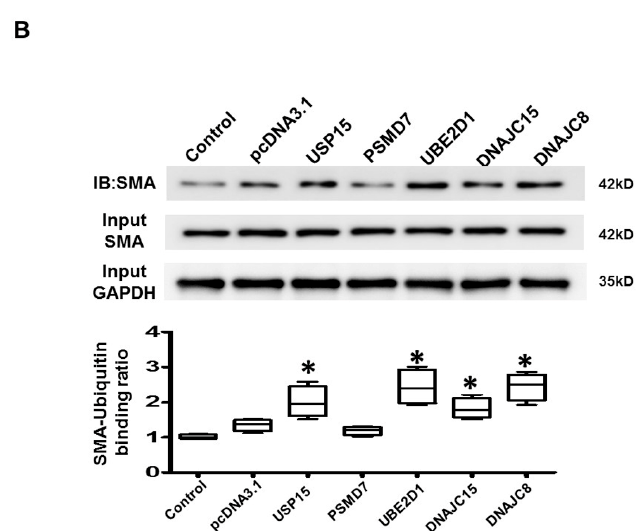
Figure 6. Effects of ubiquitination-related genes on degradation and ubiquitination of cardiac contractile proteins. ( A ) Representative images (upper panel) and box-and-whisker analysis (lower panel) of immunofluorescent staining of myosin heavy chain (MHC). Absence of red cytoplasmic fluorescence reflects MHC degradation in HL-1 cardiomyocytes. Red: MHC; blue: nuclei. ( B ) Representative blots and box-and-whisker Western blot analysis of α -smooth muscle actin (SMA) immunoprecipitated with ubiquitin. The relative expression levels of proteins corresponding to GAPDH were quantified by densitometry. * p < 0.05 versus control, n = 3 to 5 samples for each experiment.